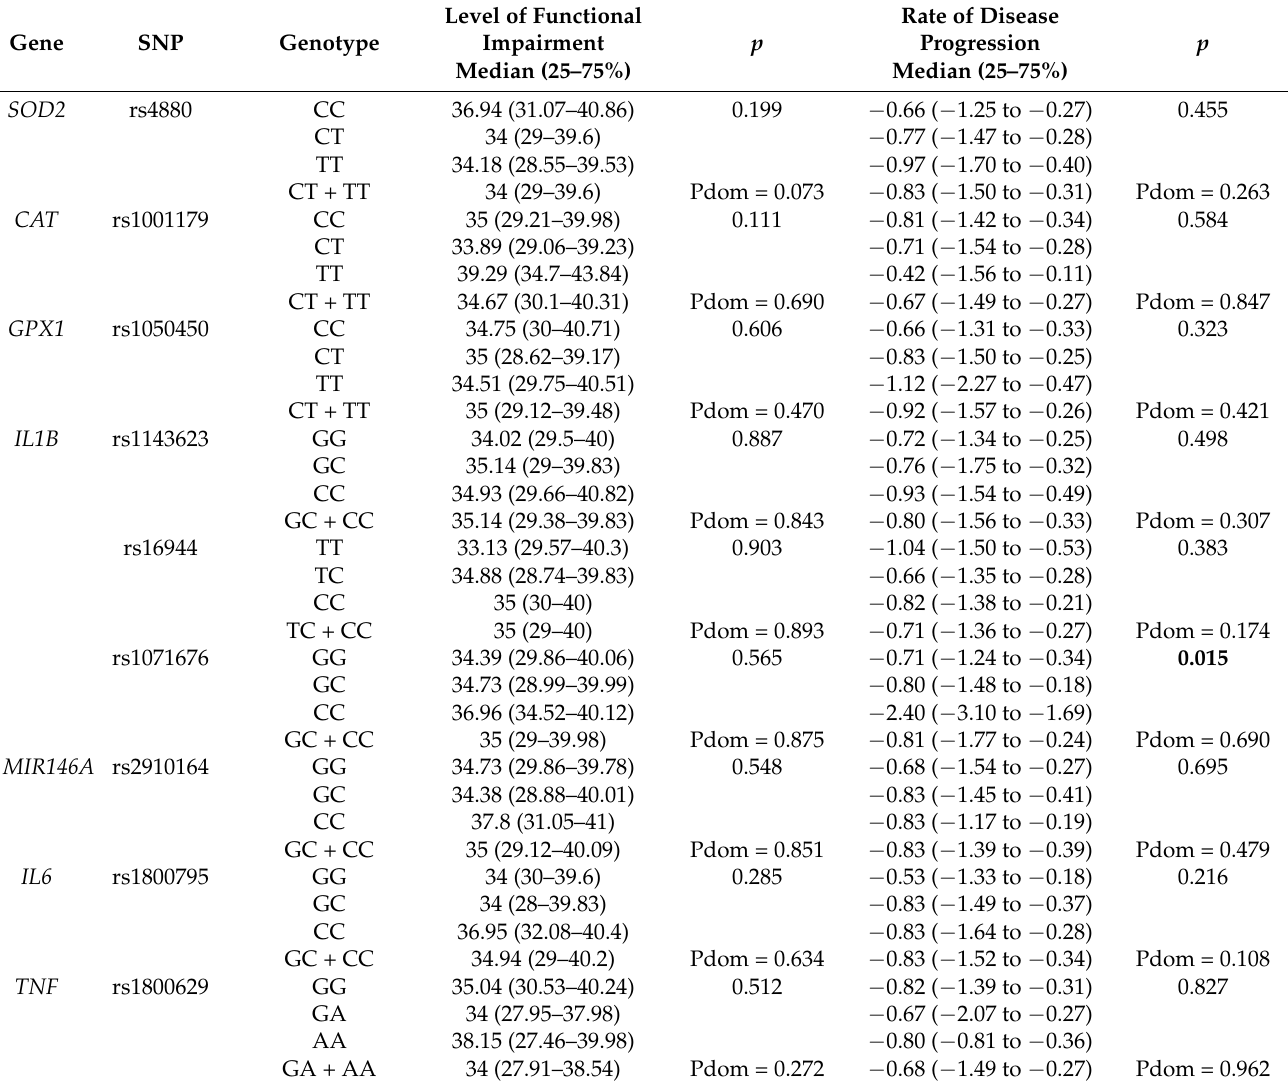
Table 4. Association of investigated SNPs with level of functional impairment and rate of disease